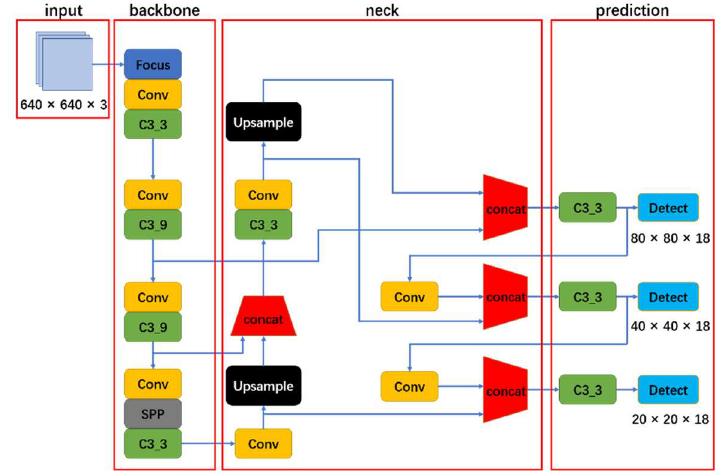
Figure 2. Yolov5 model structure.